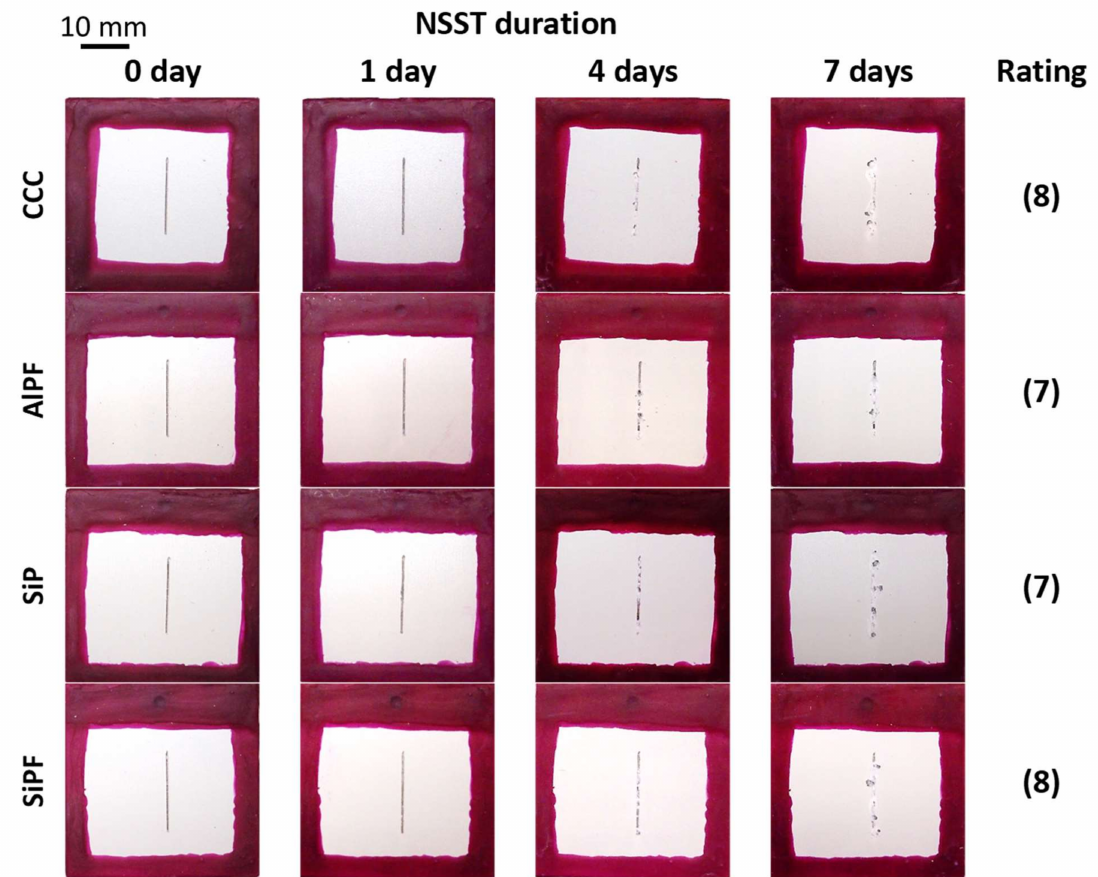
Figure 4. Macrographs of corrosion progress on CCC, AlPF, SiP, and SiPF painted and scratched samples during one week of NSST with corresponding rating